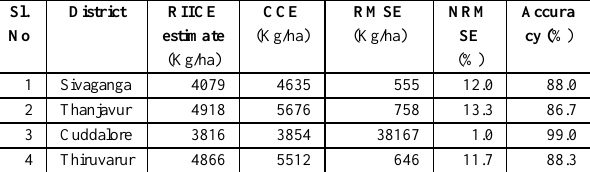
Table 6. RIICE CCE data vs. ORYZA2000 yield estimates